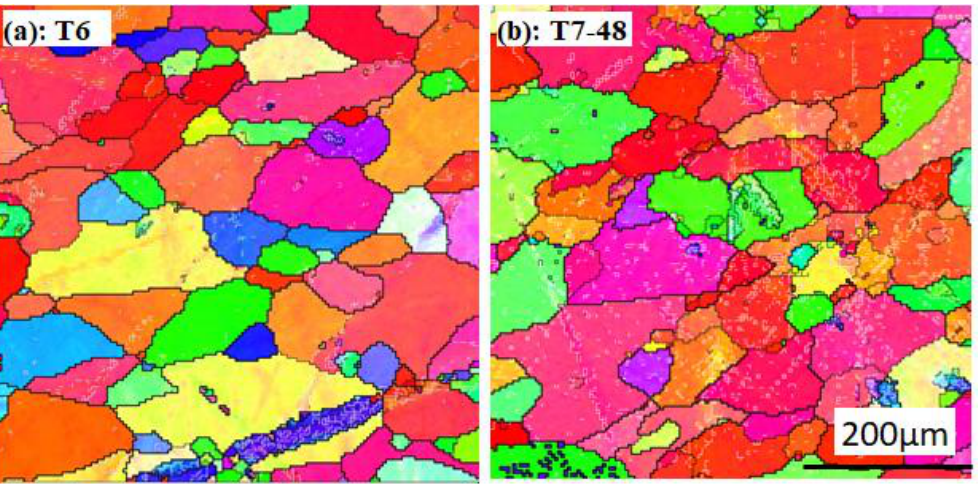
Figure 3. Electron back-scattered diffraction (EBSD) mapping results showing the grain structure under ( a ) T6 and ( b ) T7-48 conditions.